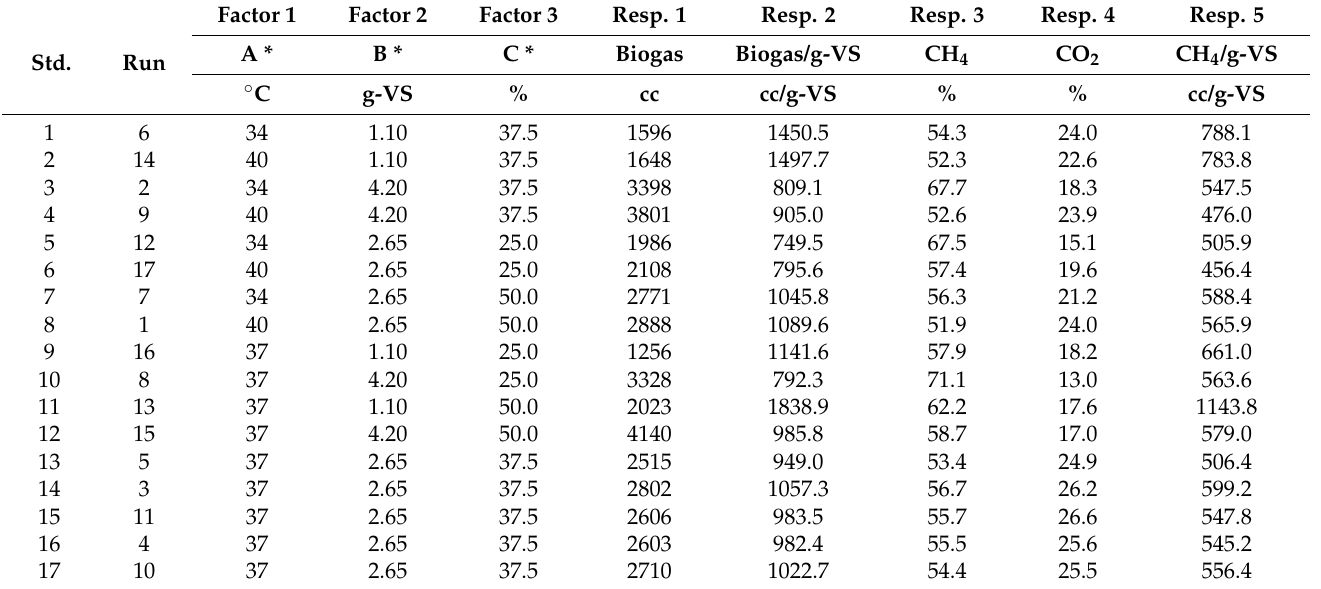
Table 4. The experiment responses results for date